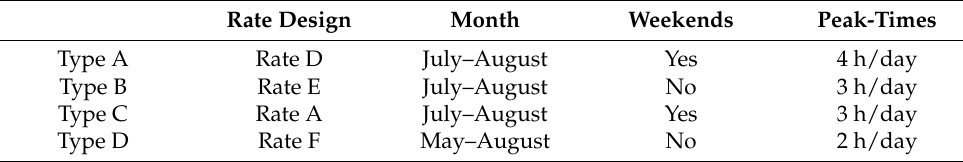
Table 2. Choice set example of TOU tariff in the one-to-one individual